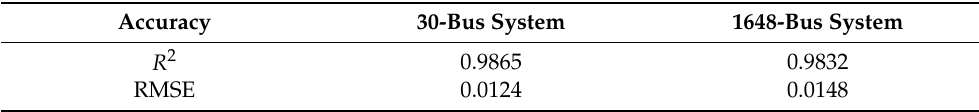
Table 1. Accuracies of the tests for the two